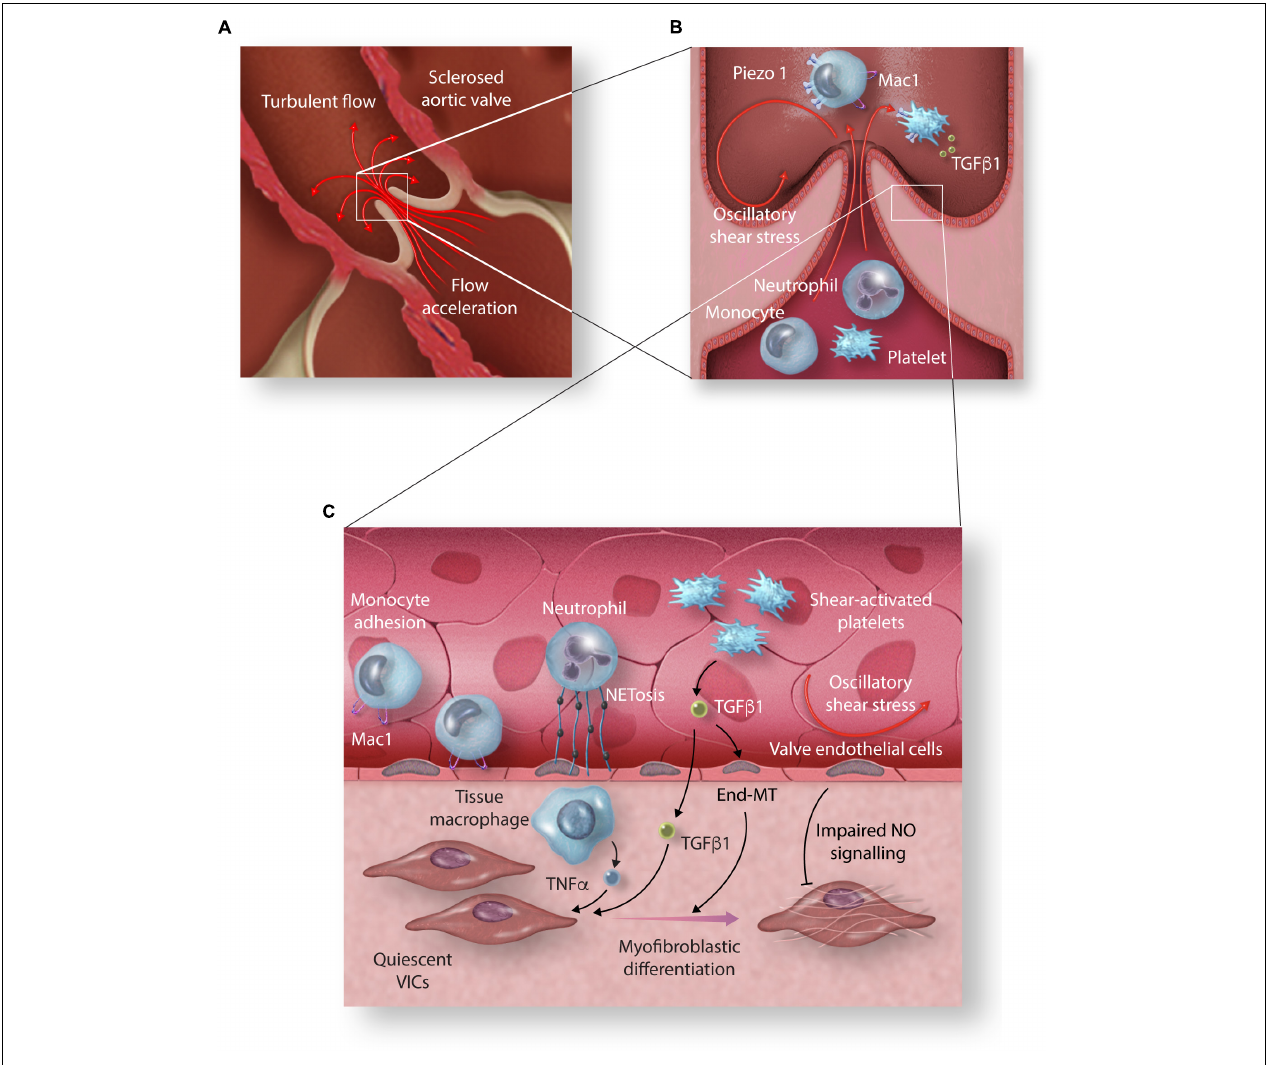
FIGURE 2 | The effect of high shear stress on circulating cells and their role in promoting valvular inflammation. (A) Acceleration of blood velocity through the narrowed aortic valve exposes circulating cells to high shear stress (HSS) and creates turbulent flow vortices on the aortic side of the aortic valve leaflets. (B) HSS induces increased expression of monocyte adhesion molecule Mac1 mediated by increased expression and activation of Piezo1. (C) TNF α released by tissue macrophages, TGF β released by HSS-activated platelets, and NETosis of shear activated neutrophils promote myofibroblastic differentiation of aortic valve interstitial cells (VICs). Increased magnitude oscillatory shear stress (OSS) promotes End-MT and impaired protective NO signalling (End-MT, endothelial-mesenchymal transition; Mac1, macrophage-1 antigen; TGF- β 1, transforming growth factor β 1; TNF- α , tumour necrosis factor-alpha; NET, neutrophil extracellular trap; NO, nitric